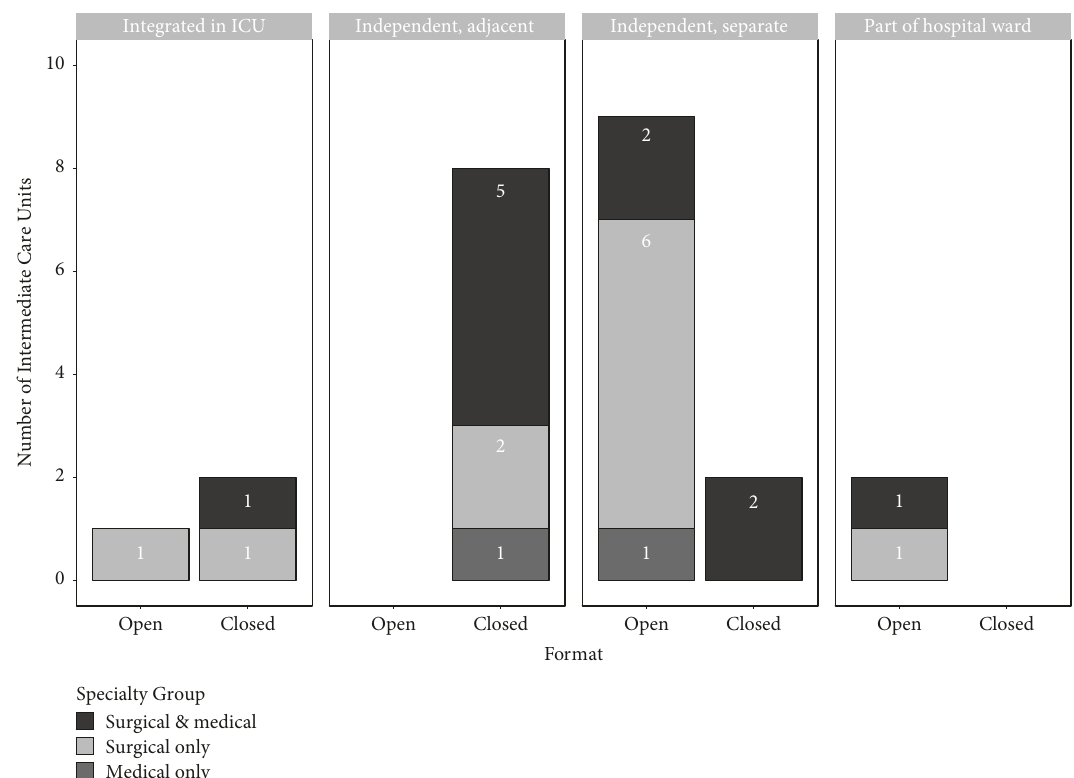
Figure 3: Number of Intermediate Care Units per location, format, and admitting specialties. This chart shows that most of the Intermediate Care Units were either (1) closed format, adjacent to the Intensive Care Unit and treating surgical and medical patients, or (2) open format, independently located and treating surgical patients